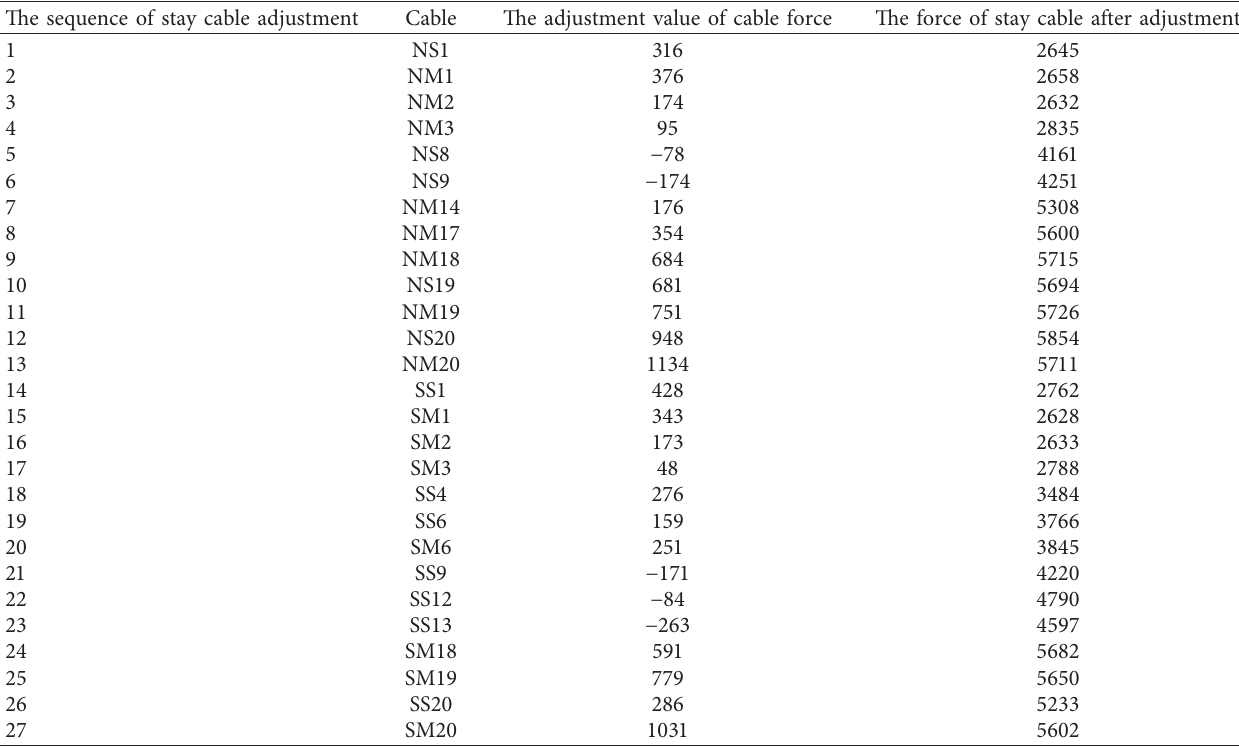
Table 4: The adjusted values of cable forces (14th calculation) (kN). The sequence of stay cable adjustment Cable The adjustment value of cable